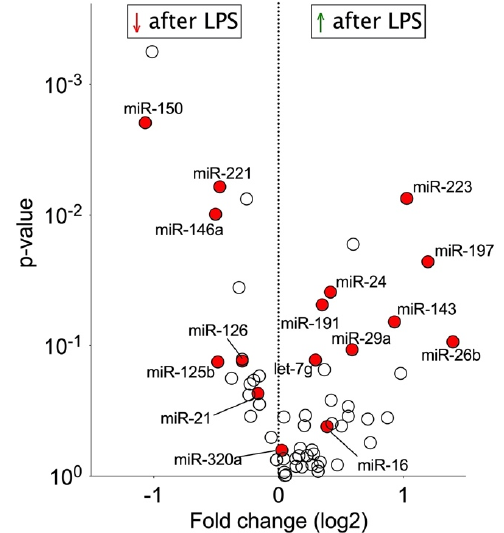
Figure 2. Circulating miRNA levels after endotoxemia. Volcano plot representing log2 fold change of miRNA levels 6 hours after endotoxin infusion in healthy volunteers without antiplatelet therapy ( n = 6). Leukocyte-enriched miR-150 showed strongest fall in abundance, while platelet-enriched miR-197 and miR-223 showed the strongest rise. MiRNAs highlighted in red were selected for qPCR analysis in the entire cohort. Student’s t-tests were used to calculate p